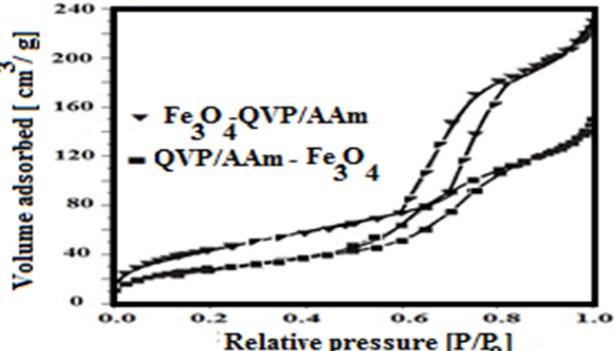
Figure 9. BET data of the prepared Fe 3 O 4 -QVP / AAm, QVP / AAm-Fe 3 O 4